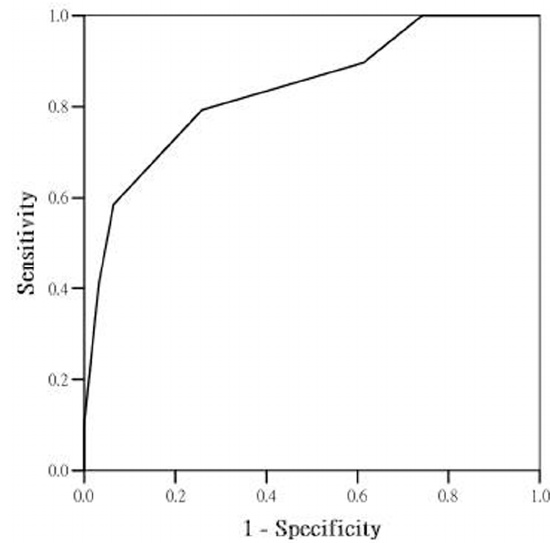
Figure 1. Receiver operating characteristic curve (ROC) of the scoring system used to predict the degree of myocardial diffuse fibrosis. The area under curve is 0.838.